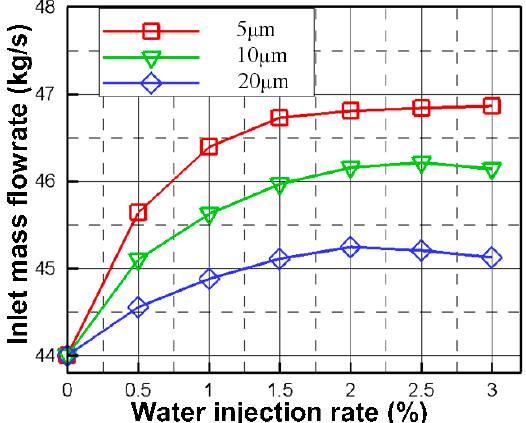
Figure 16. Comparison of inlet mass flowrate under dry and water injection cases.